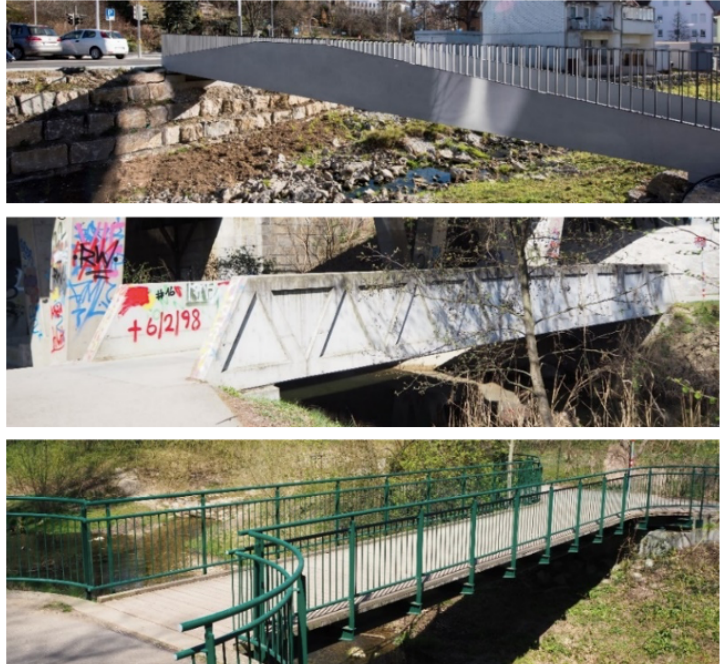
Figure 8. Pedestrian bridge examples, from top to bottom: B1-CCB (solidian GmbH), B2-RCB and B3-SB (Mathias Hammerl).